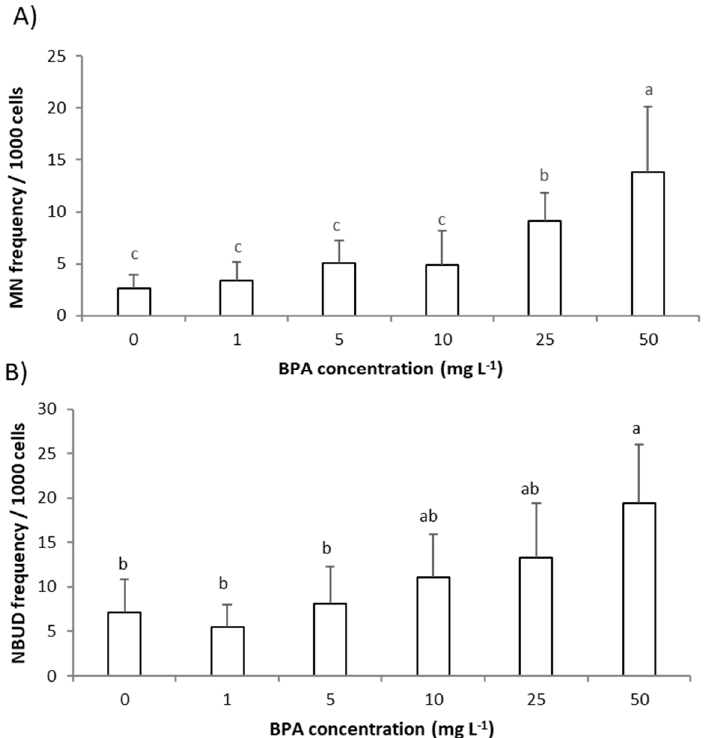
Figure 2. Genotoxic effect of bisphenol A (BPA) to Allium cepa roots exposed to BPA (1–50 mg L –1 ) for 3 days. Genotoxicity was assessed as: ( A ) frequency of micronucleus (MNs) and ( B ) frequency of nuclear buds (NBUDs) of interphasic nuclei in meristem cells of A. cepa roots. Results are presented as means ± SD (on 4000 cells per treatment). Different letters indicate significant difference ( p ≤ 0.05). 0—control plants, not exposed to BPA.